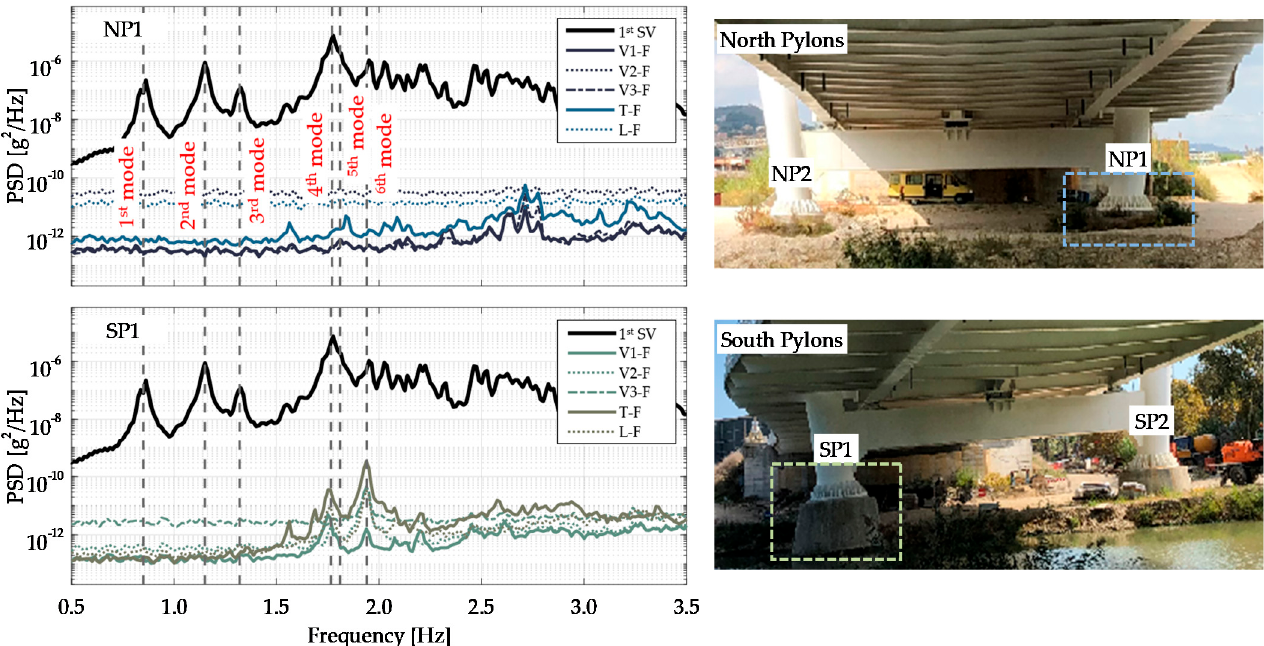
Figure 22. Frequency content of the foundation system and relevant pictures.